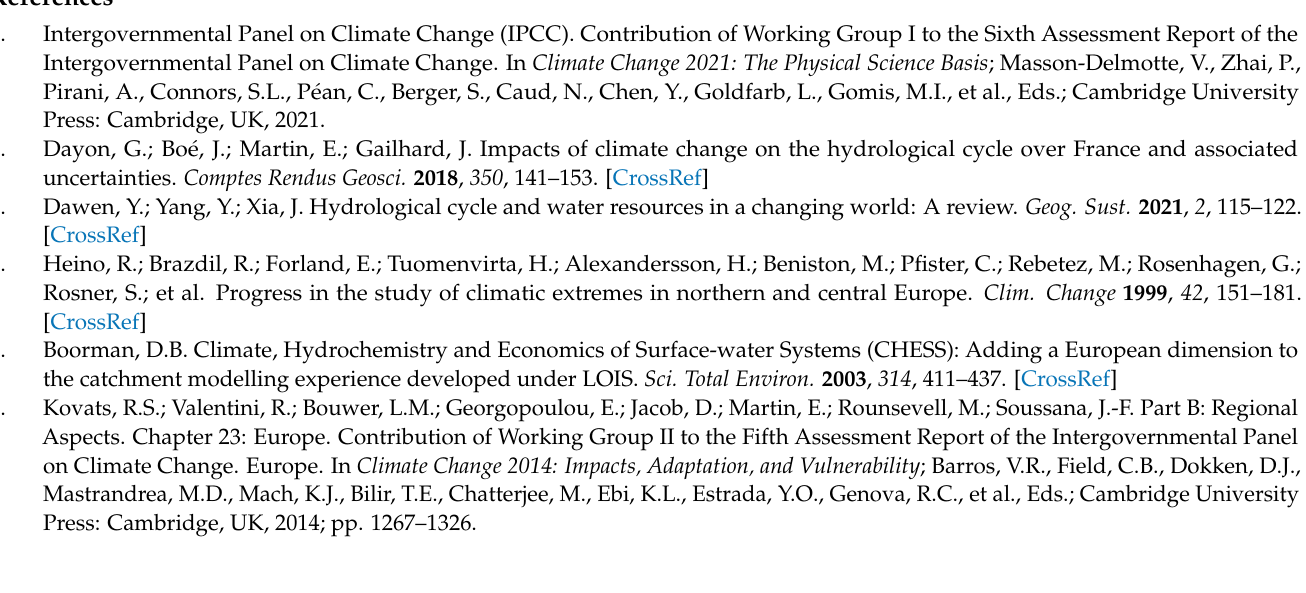
Table S1. Parameters adjusted during SWAT model calibration; Table S2. Averages for temperature, precipitation and associated climate indicators for each climate model output for the reference, short- and long-term periods; Table S3. Monthly values for the temperature and precipitation based climate indicators for the representative year for each climate model ensemble output for the reference, short- and long-term periods (catchment scale); Table S4. Monthly values for main water balance components for the representative year for each climate model ensemble output for the reference, short- and long-term periods (catchment